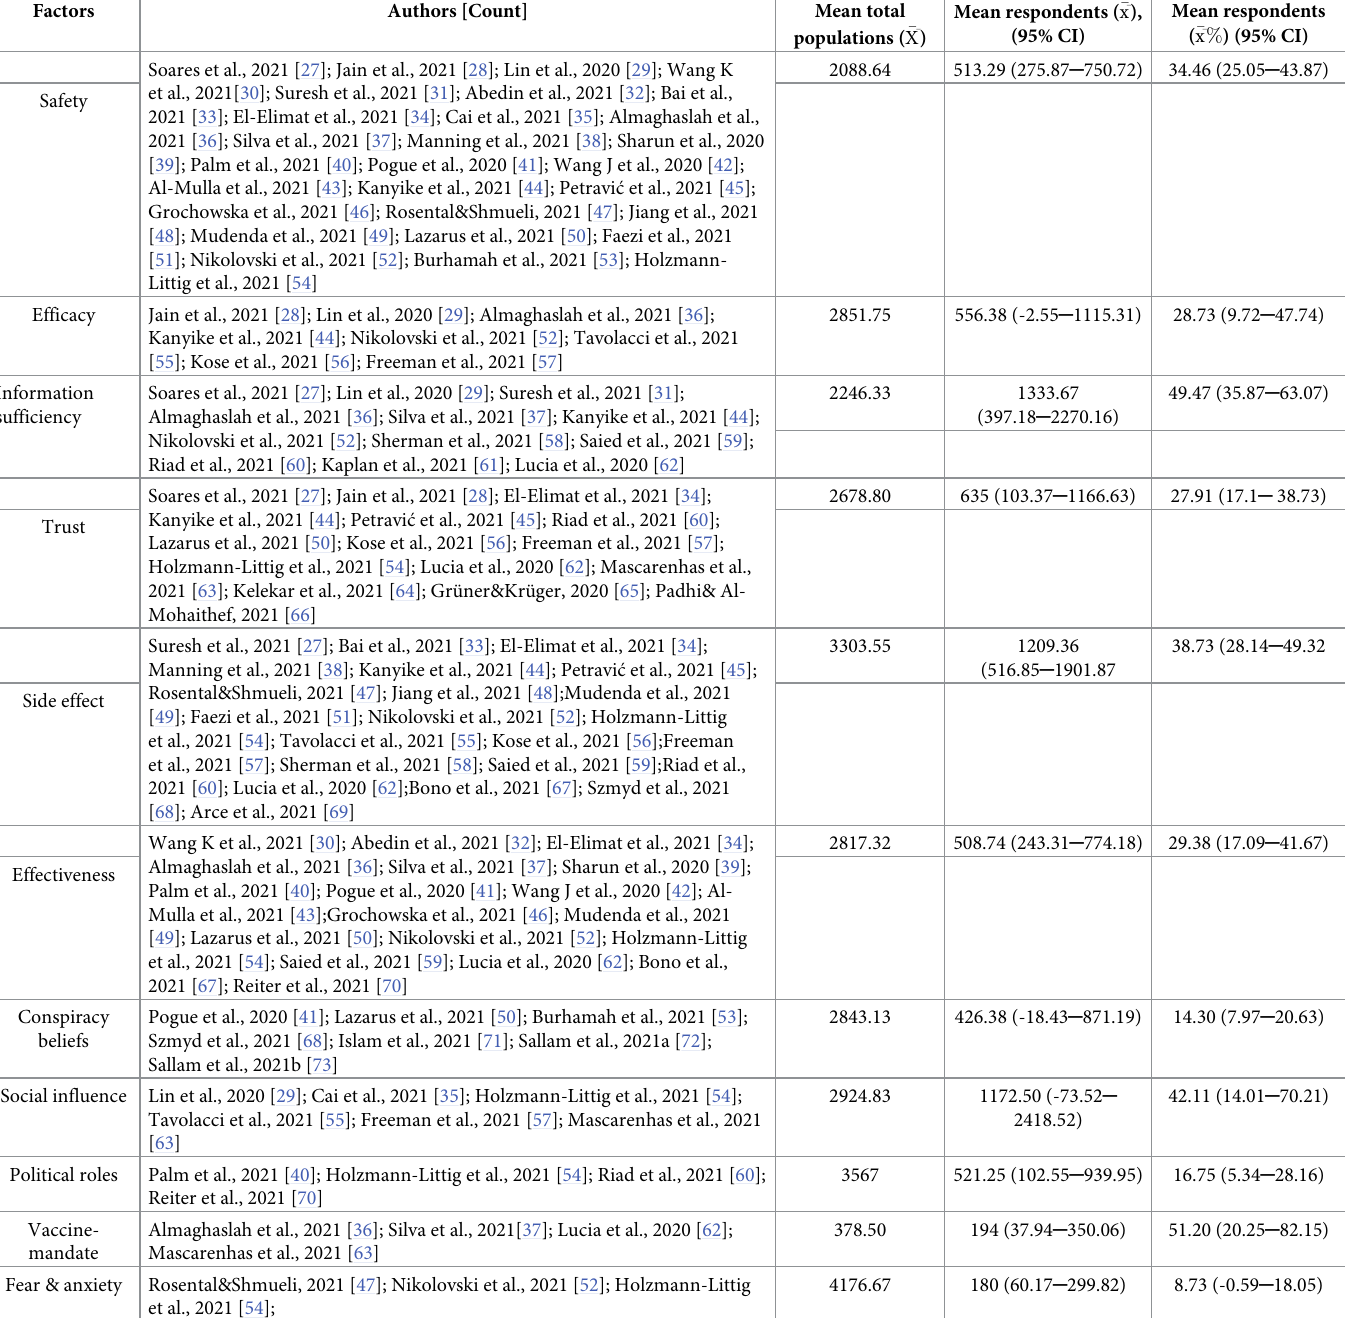
Table 1. Potential factors associated with COVID-19 vaccine acceptance and